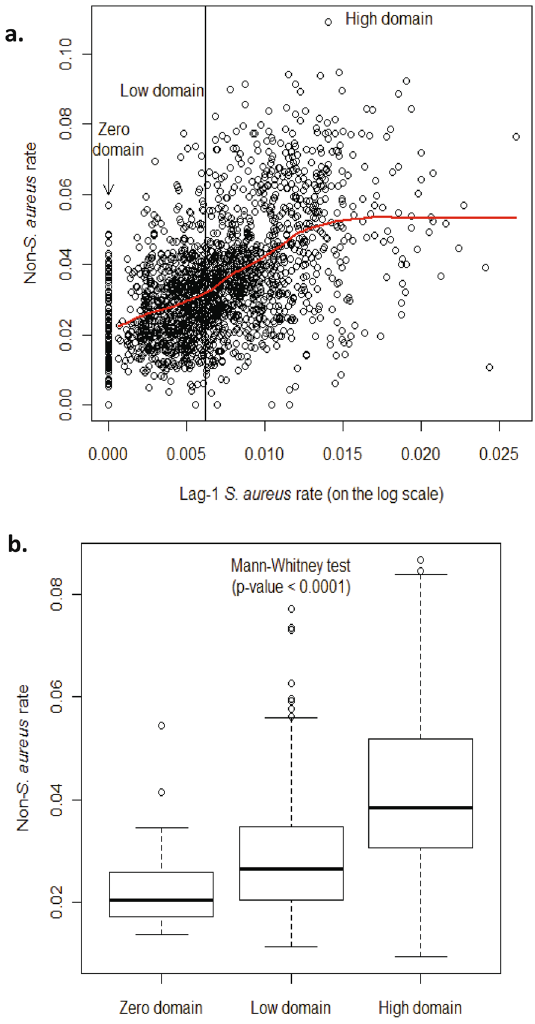
Figure 1. ( a ) Plot of the rate of non- S. aureus infections versus the threshold variable, namely the (log- transformed) lag-1 S. aureus rate. The zero domain corresponds to a domain such that the lag-1 S. aureus rate being equal to zero. The vertical line shows the location of the threshold estimate that defines two non-zero regimes: the low domain and the high domain. The red curve explores nonparametrically the mean of the non- S. aureus rate as a function of the lag-1 S. aureus rate, by fitting a local regression model. The shape of this red curve attests that the underlying process is nonlinear. ( b ) Boxplots of the fitted non- S. aureus rate in each of the 3 domains (zero, low, and high domains). The zero-domain median of the fitted non- S. aureus rate is significantly lower than the low-domain median (Mann–Whitney test; p value < 0.0001); the low-domain median of the fitted non- S. aureus rate is significantly lower than the high-domain median (Mann–Whitney test; p value <